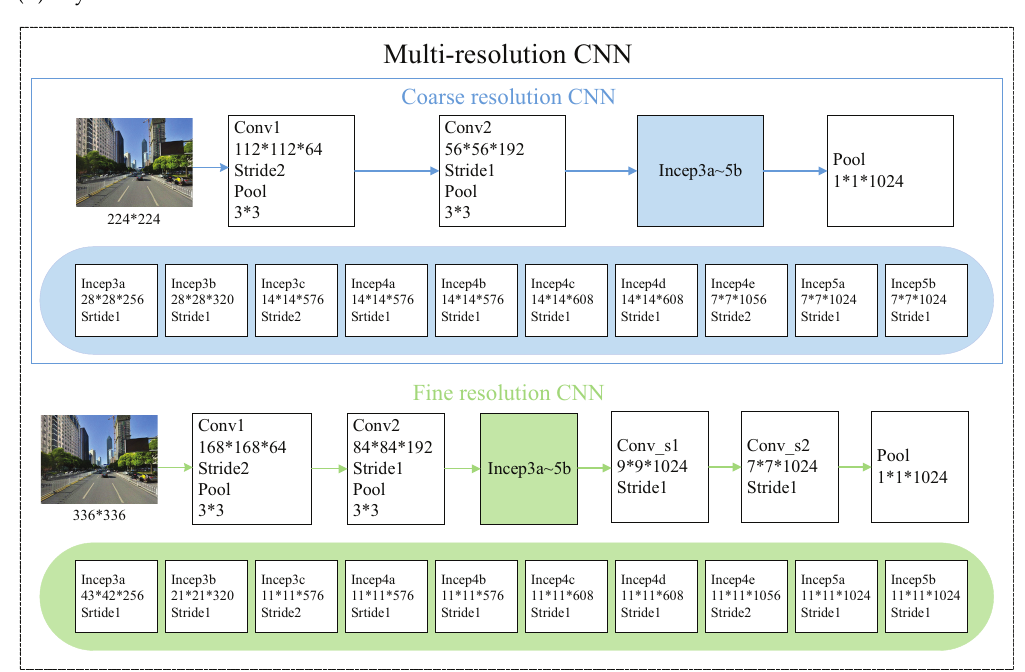
Figure 15. The structure of multi-resolution CNN proposed in